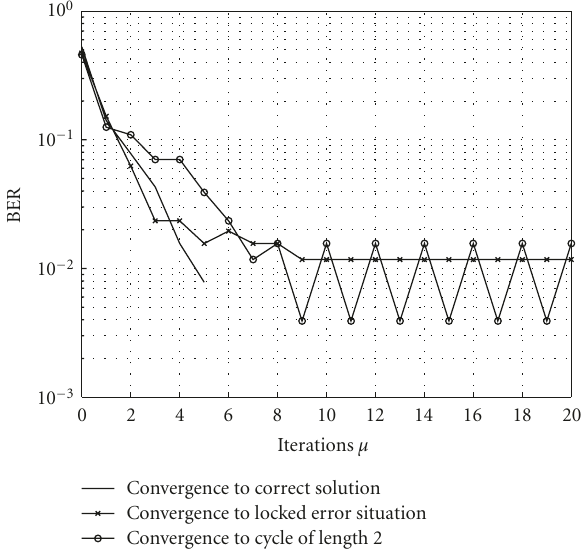
Figure 5: Possible convergence behavior for IHDIC with parallel ( E b / N 0 ) = 15 dB, synchronous DS-CDMA update for 10log 10 transmission over an AWGN channel with V = 64 users employing 16QAM and complex-valued random spreading sequences with spreading factor L =